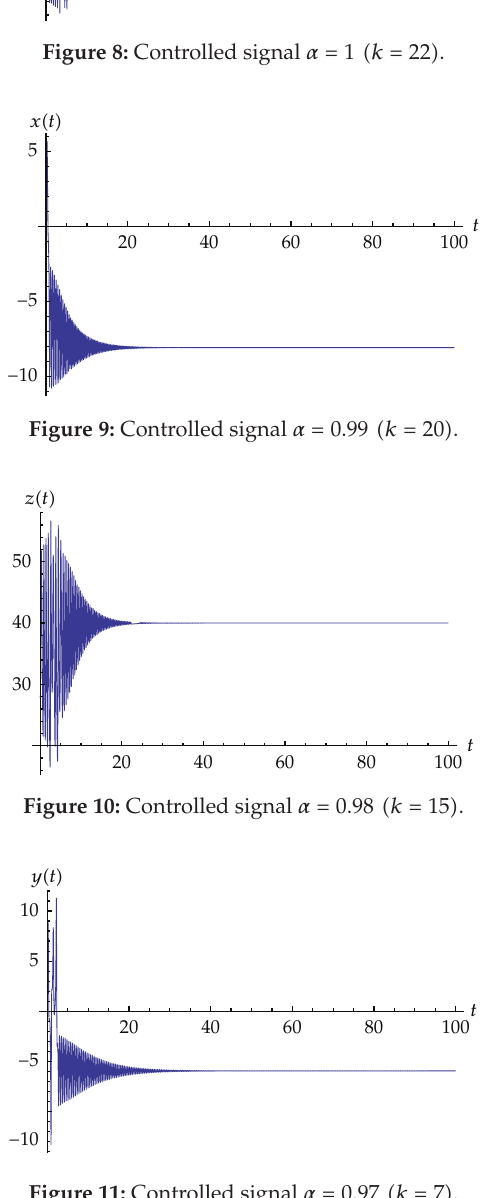
Figure 11: Controlled signal α (cid:8) 0 . 97 (cid:3) k (cid:8) 7 (cid:4)